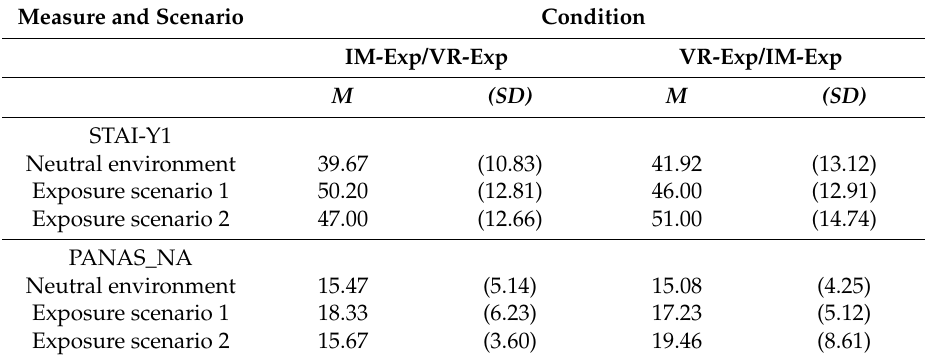
Table 2. Means and standard deviations of dependent variables in each experimental condition for the three